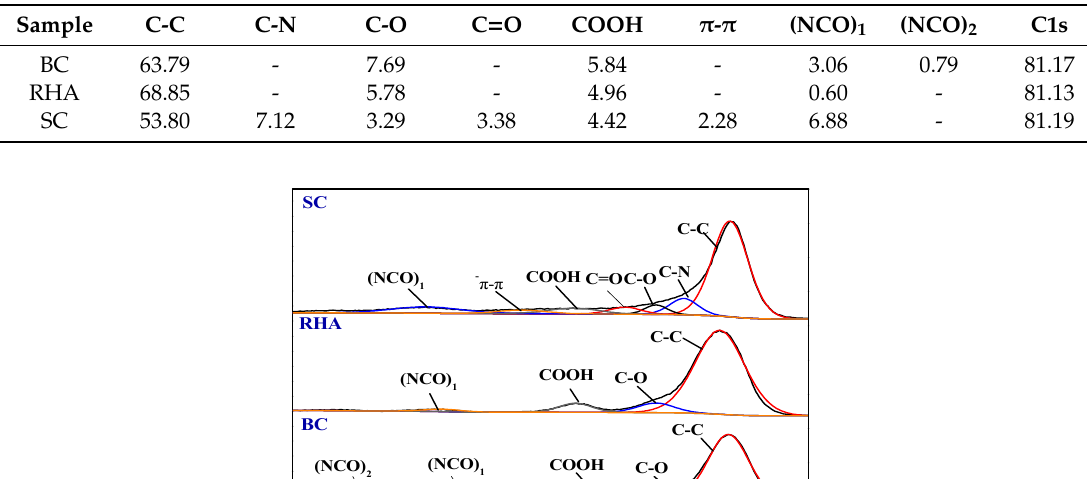
Table 4. C1s fitting peaks of three biochars.